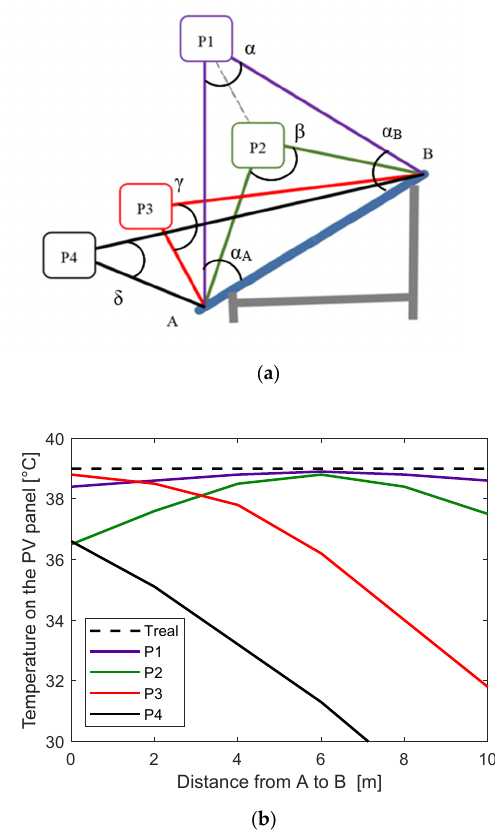
Figure 13. ( a ) View angle between the PV array (blue line) and the IR camera position. ( b ) Detected temperatures along the array, based on the UAV position.